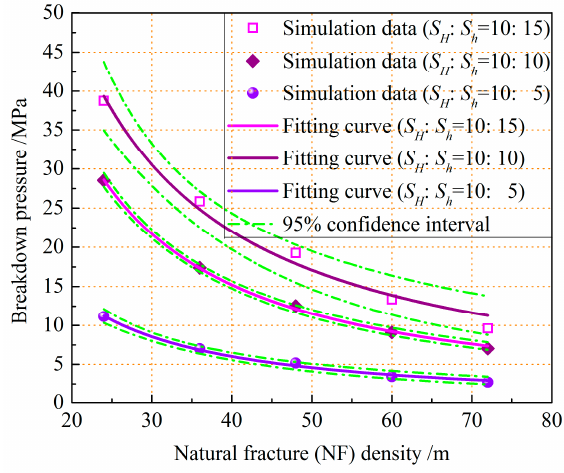
Figure 21. Variation of breakdown pressure with NF density under different confining pressure ratios and injection rate is 2.0 × 10 − 6 m 3 /s. Table 5. Fitting curve equations of beakdown pressure under different confining pressure ratios Confining Pressure Ratios Fitting Curve Equations